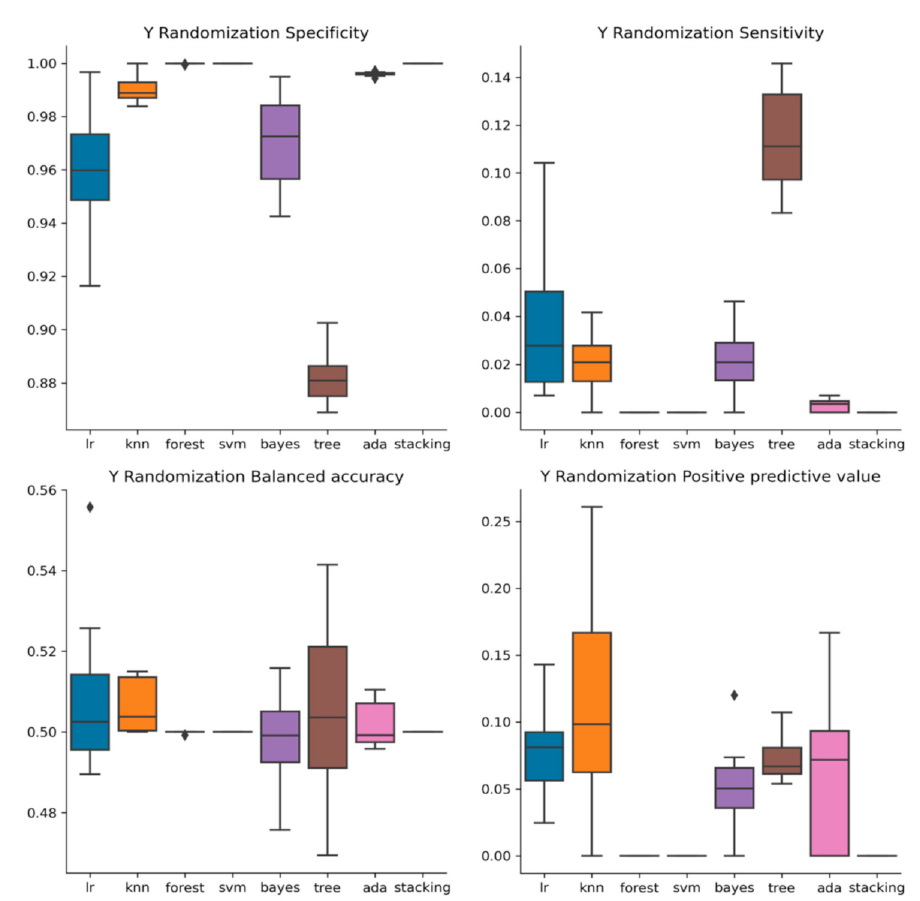
Figure 3. The performance of the QSAR models built with y-randomized data is inferior to that of the QSAR models developed with the non-permuted data